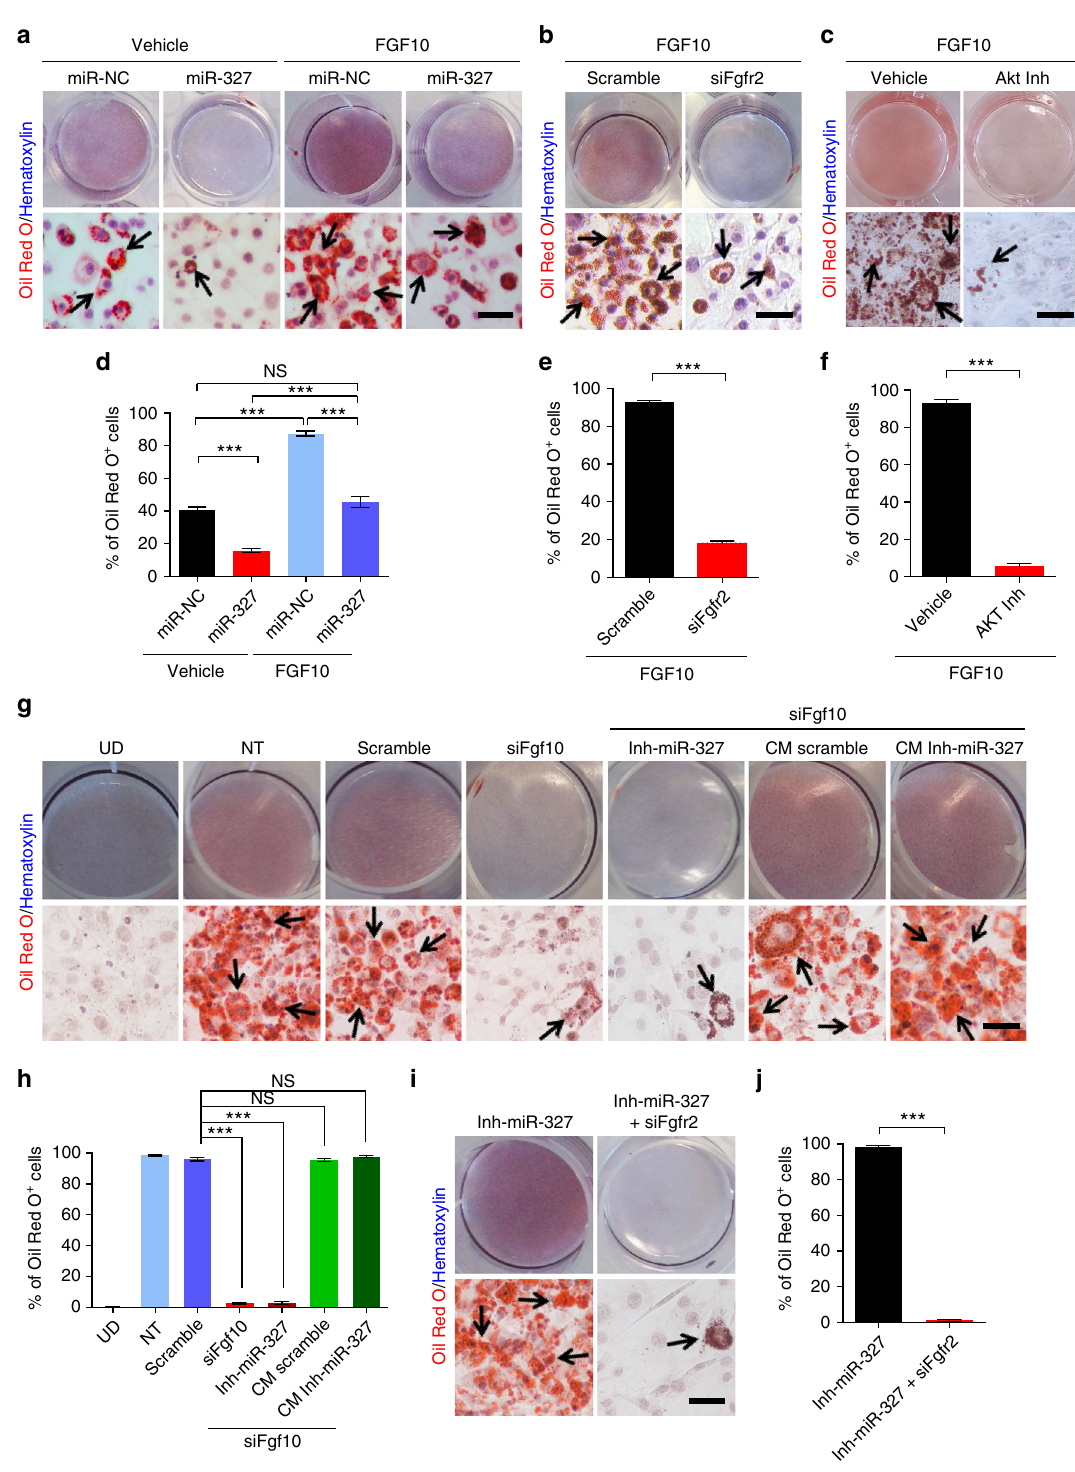
Fig. 6 FGF10-induced FGFR2 activation is an essential process for preadipocyte differentiation. a – c The effects of miR-NC, miR-327, Scramble, siRNA-Fgfr2 (siFgfr2), and an Akt inhibitor (Akt Inh) on vehicle- and FGF10-induced 3T3-L1 preadipocyte differentiation visualized by Oil Red O and hematoxylin double staining. d – f Quanti fi cation of differentiated Oil Red O + adipocytes as percentages of total adipocytes. g Differentiation of 3T3-L1 preadipocyte under various treated and non-treated conditions: Undifferentiated (UD); Non-treated (NT); Scramble; siFgf10-treated; siFgf10 plus Inh-miR-327; siFgf10 plus conditioned medium (CM) from Scramble-transfected preadipocytes; and siFgf10 plus conditioned medium (CM) from Inh-miR-327-transfected preadipocytes. h Quanti fi cation of average percentages of differentiated Oil Red O + adipocytes vs. total cells. i , j Detection of adipocyte differentiation by Oil Red O + and hematoxylin double staining of Inh-miR-327- and Inh-miR-327 plus siFgfr2-treated 3T3-L1 preadipocytes. a – j Arrows indicate differentiated Oil Red O + adipocytes. Scale bars, 100 μ m. Quanti fi cation of differentiated Oil Red O + adipocytes as percentages of total adipocytes ( > 30 adipocytes per fi eld; n = 10 random fi elds). NS, not signi fi cant. * P < 0.05, ** P < 0.01, and *** P < 0.001 by Student ’ s t -test. Data presented as mean ±